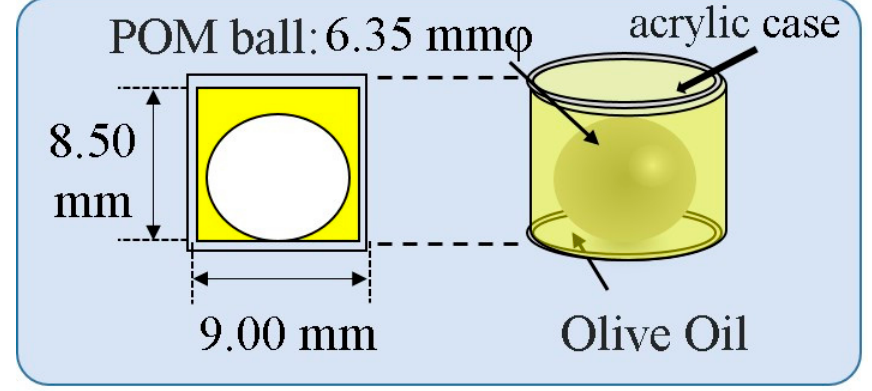
Figure 2. MR-visible fiducial marker. (POM: polyoxymethylene).